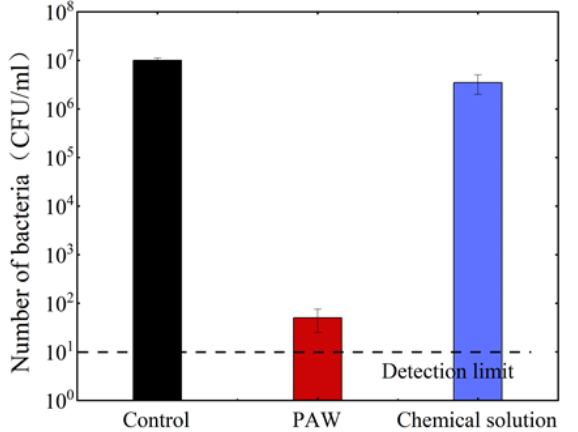
Figure 14. Comparison of the sterilization effect of PATW and a chemical mixed solution of a slightly higher concentration.